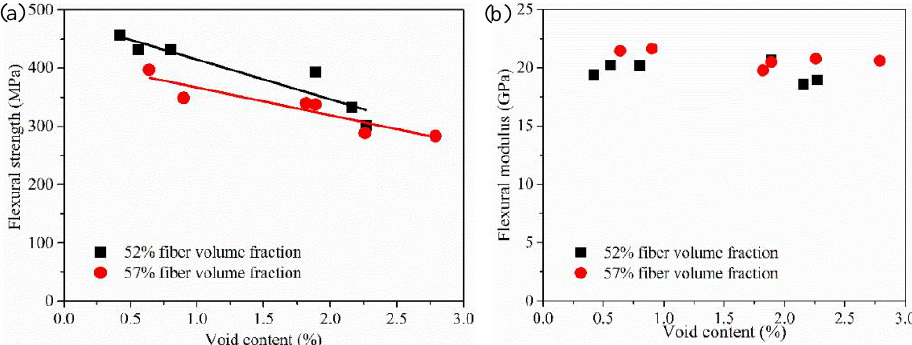
Figure 9. ( a ) Flexural strength and ( b ) flexural modulus with different void content and fiber volume fraction.